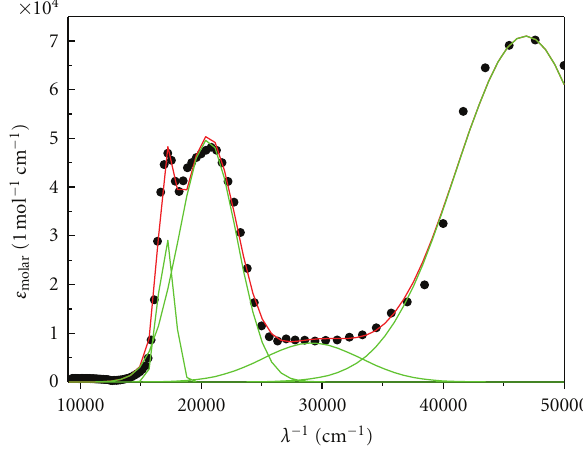
Figure 12: The volume energy loss functions and the surface energy loss functions against h ν for PTDCI